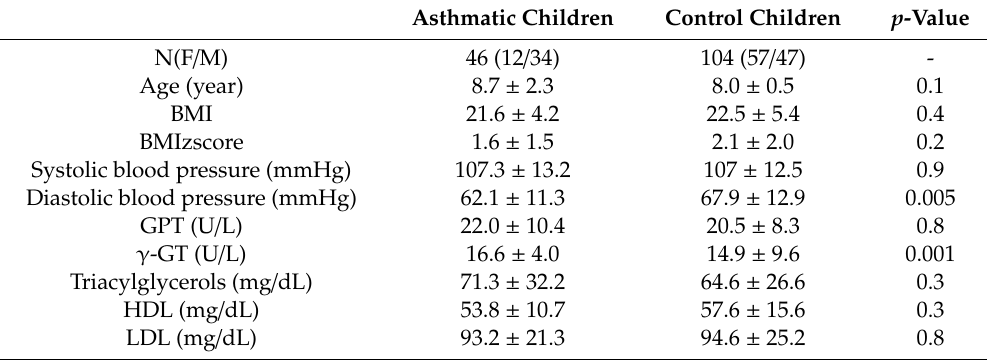
Table 3. Characteristics of the BIOASMA cohort compared to control